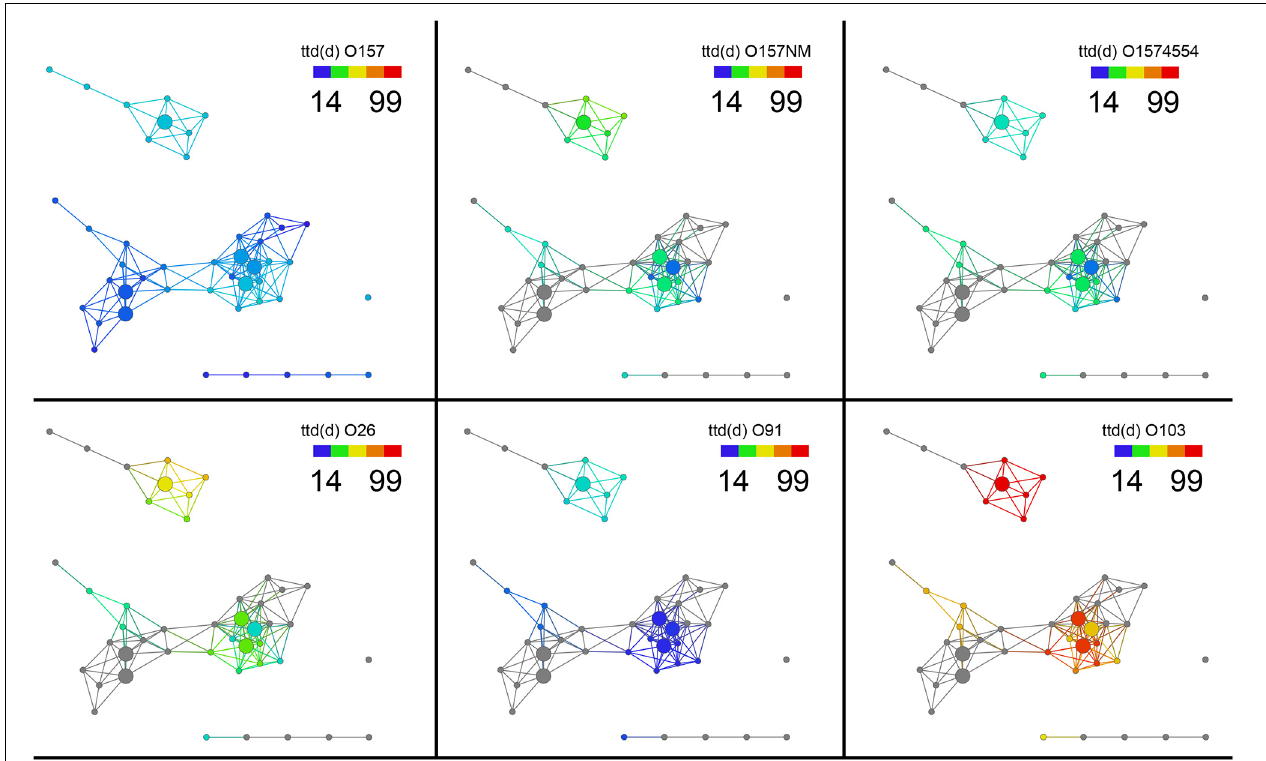
FIGURE 4 | Survival of six E. coli O157 and non-O157 strains grouped together on a normalized scale showed that E. coli O103:H2 survived the longest in all the soils, followed by E. coli O26:H21. Gray nodes are as explained in Figure 3 . The distance metric and filters are as shown in Figure 1